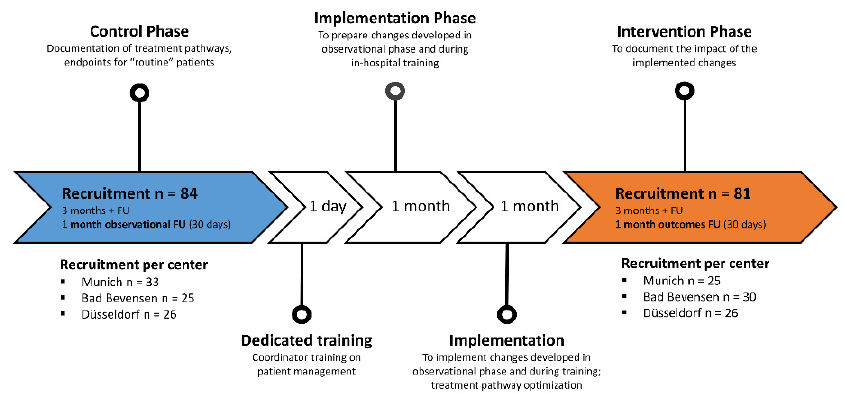
Figure 1. Study flow chart. FU, follow-up.